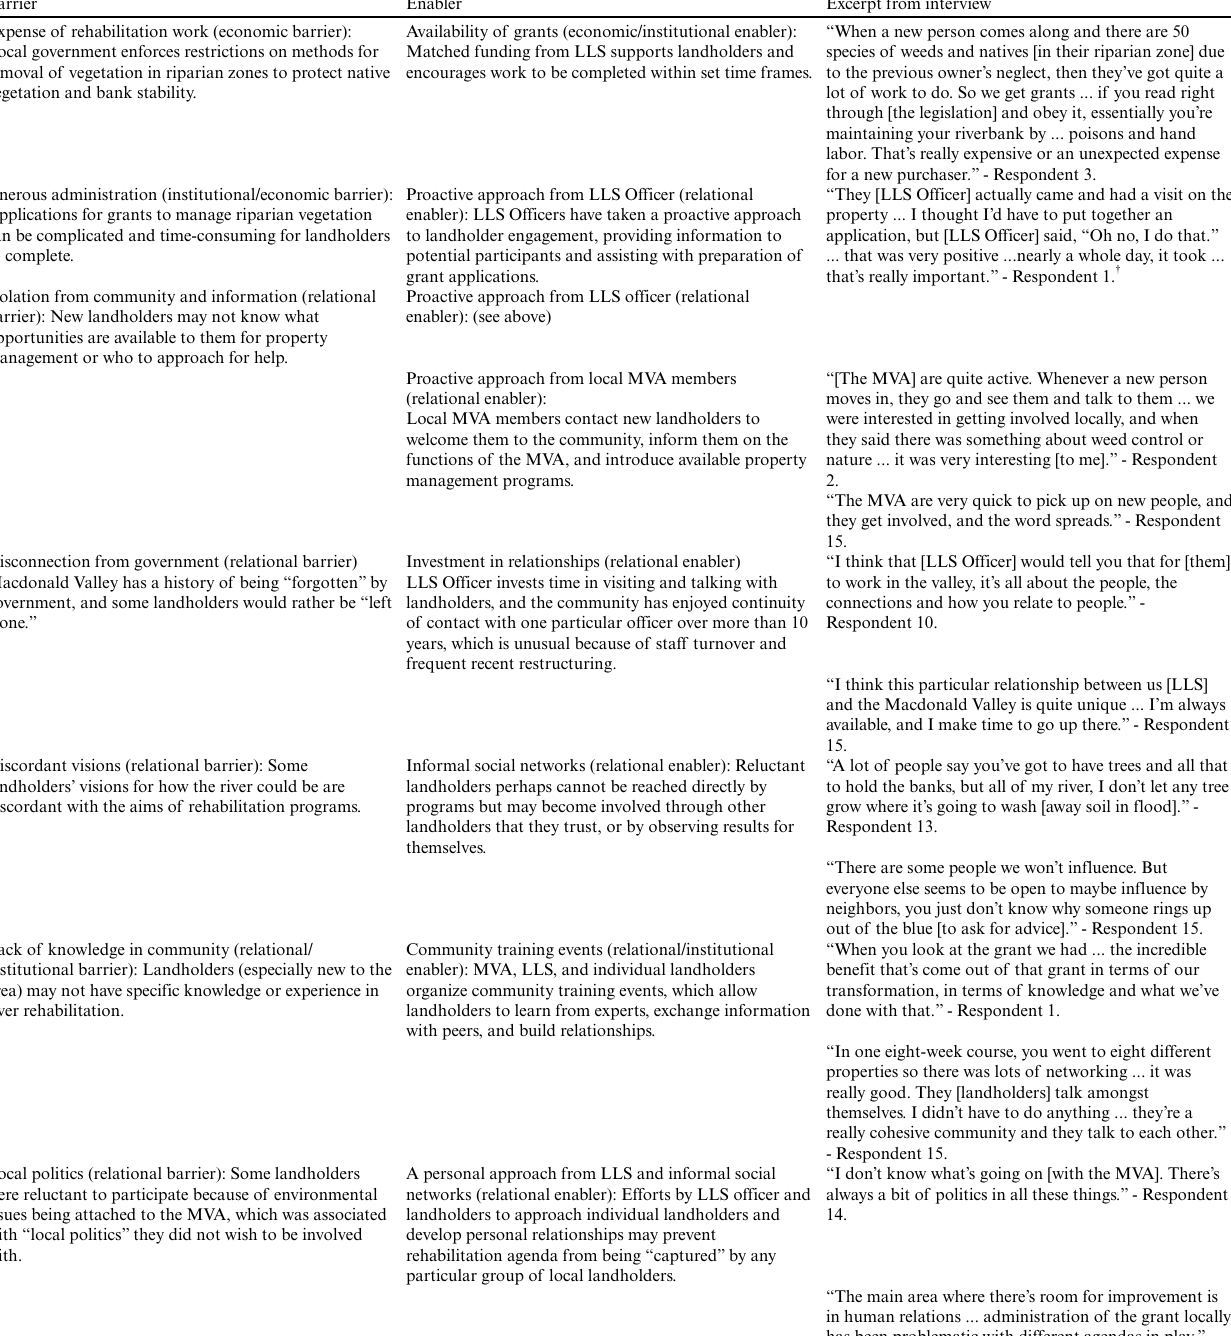
Table 6 . Enablers and barriers for participation. LLS = Local Land Services; MVA = Macdonald Valley Association. Barrier Enabler Excerpt from